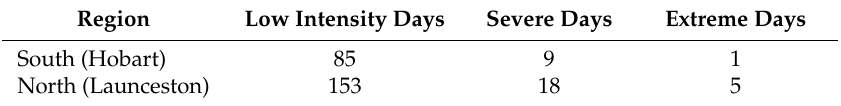
Table 3. Number of days identified as heatwave days for each region, at each heatwave